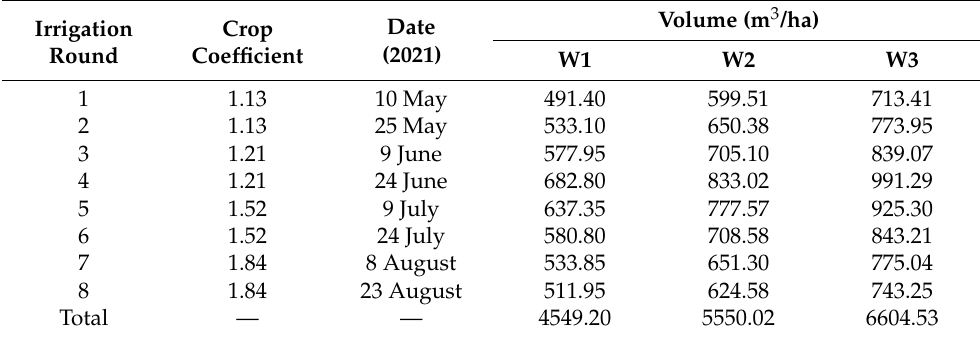
Table 2. Irrigation volumes for Korla fragrant pear in